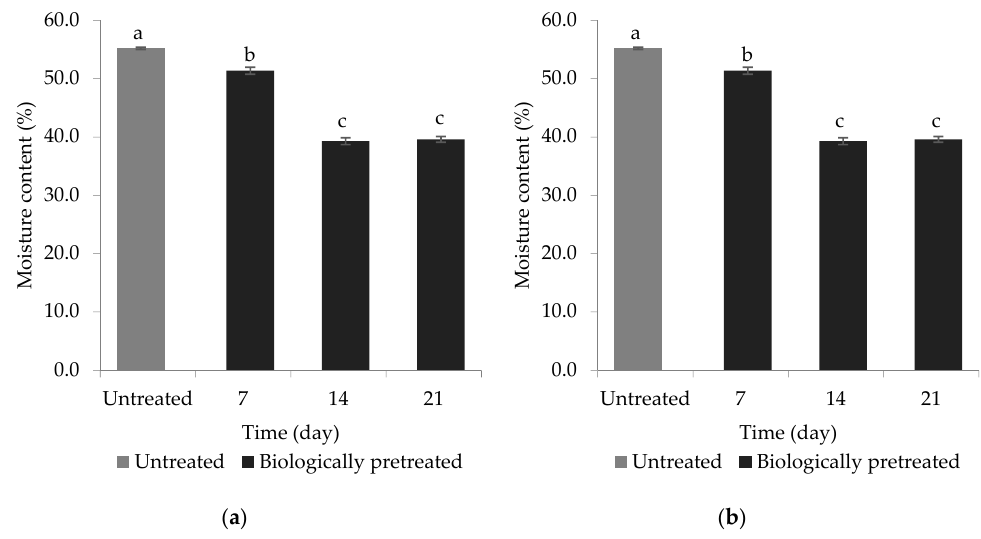
Figure 3. ( a ) Moisture content of untreated and biologically pretreated OPEFB by Schizophyllum commune ENN1; ( b ) oil residue of untreated and biologically pretreated OPEFB by Schizophyllum commune ENN1. Error bars represent the standard deviation of triplicate samples. Different letters on error bar indicate significant differences between time (day) at p < 0.05 level.